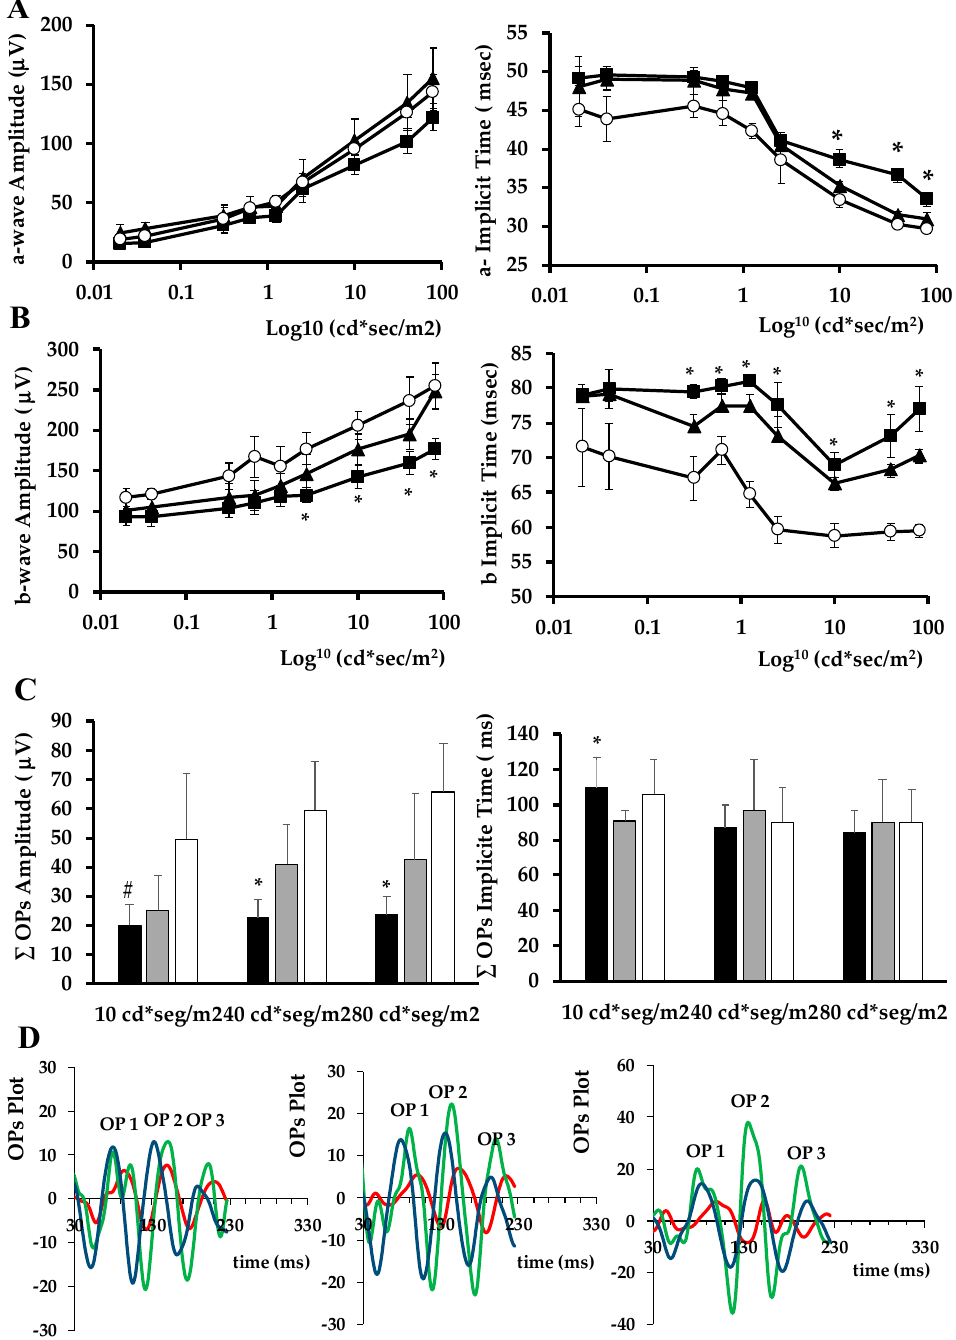
Figure 4. Effect of topical (eye drops) administration of SOCS1 peptidomimetic (MIS1) on ERG abnormalities. ( A ) Quantitative analyses of Amplitude and Implicit time of a-wave in db / db treated with vehicle ( n = 10, black square), db / db treated with MIS1 ( n = 10, black triangle) and non-diabetic mice ( n = 10, white circle). ( B ) Amplitude and Implicit time of b-wave in db / db treated with vehicle ( n = 10, black square), db / db with MIS1 ( n = 10, black triangle) and non-diabetic mice ( n = 10, white circle). ( C ) OPs Amplitude and Implicit time in the experimental groups. Results are mean ± SD. * p < 0.05 (db / db treated with vehicle vs. the other groups). # p < 0.05 (db / db treated with vehicle vs. db / db treated with MIS1). ( D ) Oscillatory potential traces in response to low, medium and high stimulus intensities (10 cd · s · m-2, 40 cd · s · m-2 and 80 cd · s · m-2) in a representative non-diabetic mouse (green), a db / db mouse treated with vehicle (red) and a db / db mouse treated with MIS1 eye-drops